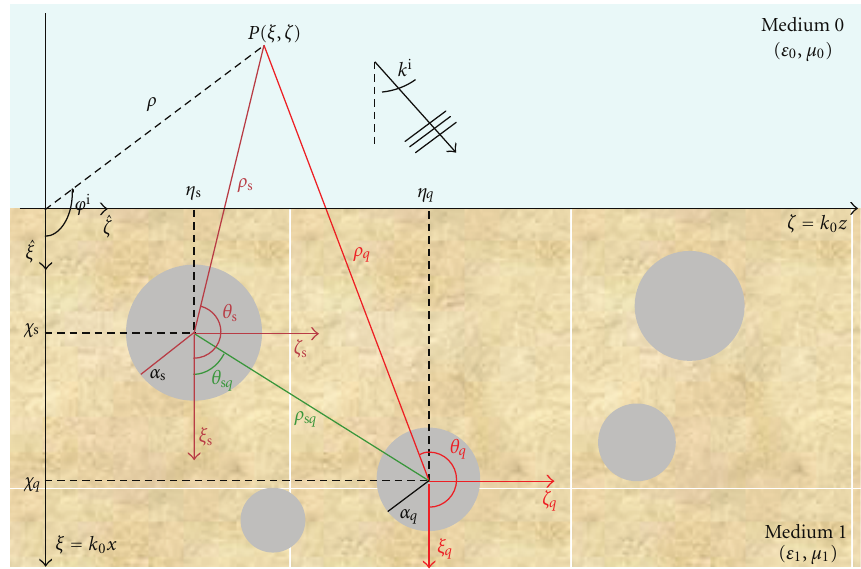
Figure 2: Geometry of the scattering problem, with cylinders buried in a dielectric